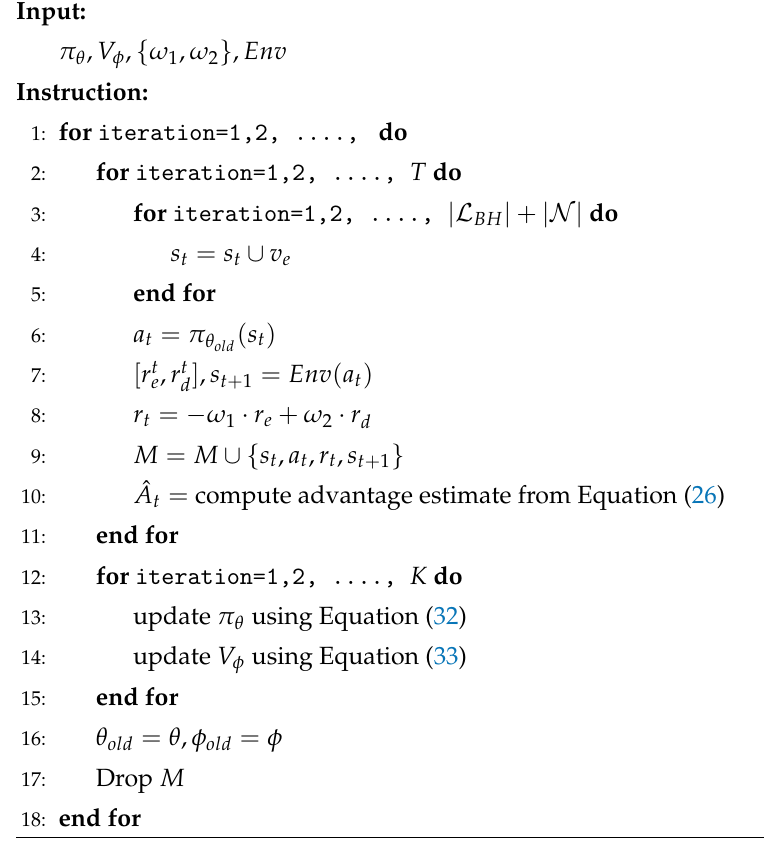
Algorithm 1 Proposed PPO Solution for mmWave